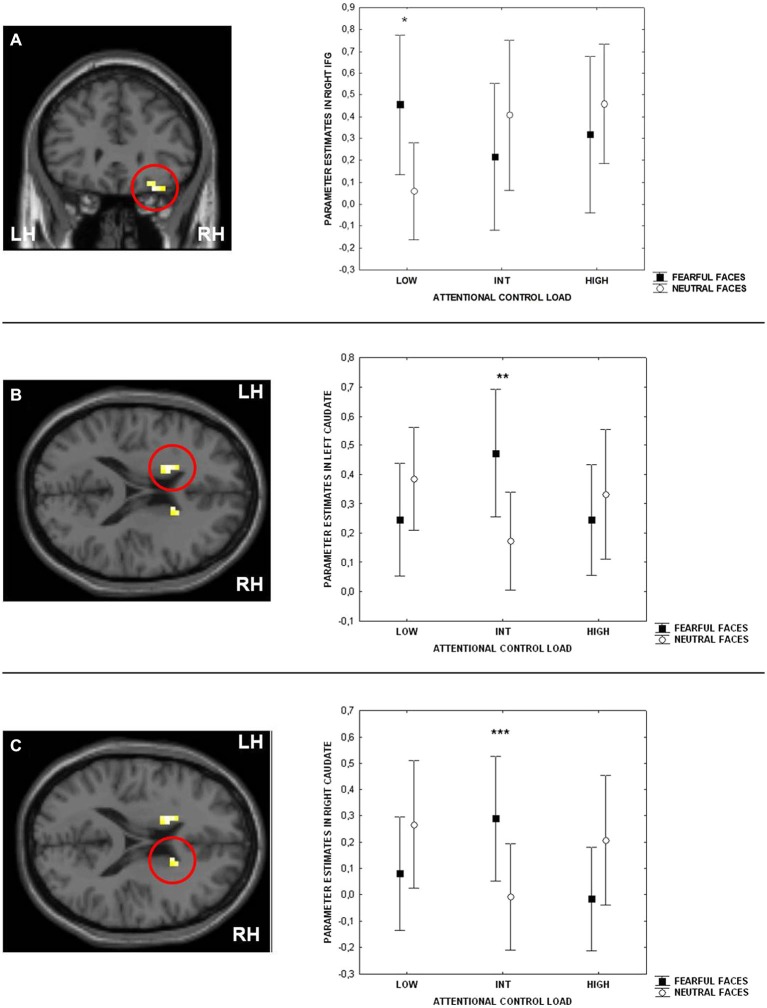
Sections of the brain showing the interaction between attentional control load and emotion in right Inferior Frontal Gyrus (IFG) (BA47) (A), left (B) and right (C) caudate. Graphs represent parameter estimates extracted from these clusters. Measures presented are mean ± standard deviations. *p = 0.004, **p = 0.001, ***p = 0.01. For more statistics, see Section Results.